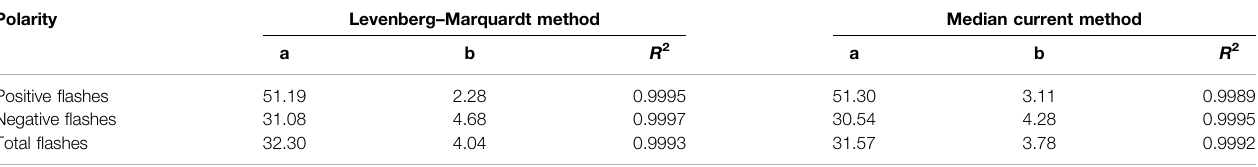
TABLE 4 | Comparison of fi tting results between the Levenberg – Marquardt method and the median current method.